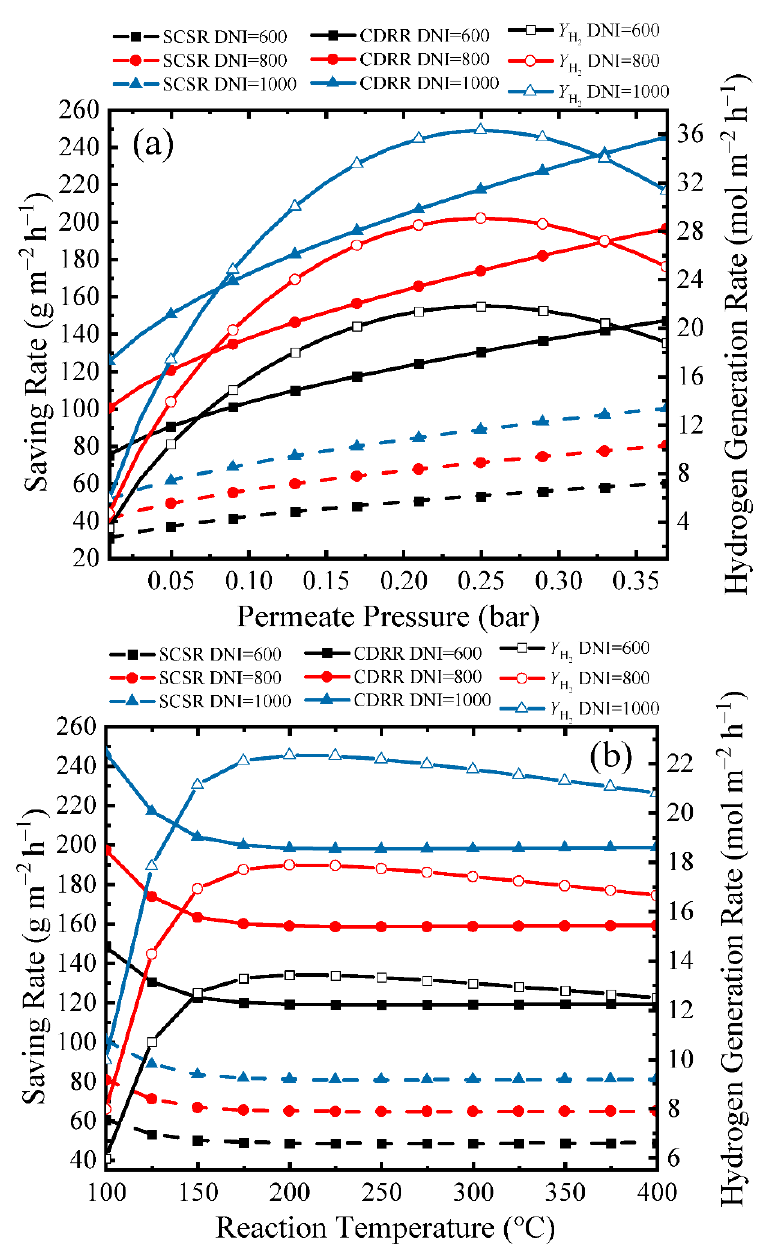
Figure 10. Variation of SCSR, CDRR, and Y H2 with real separation energy and η s → e of 15% versus ( a ) permeate pressure at a reaction temperature of 150 °C, ( b ) reaction temperature at a permeate pressure of 0.2 bar.